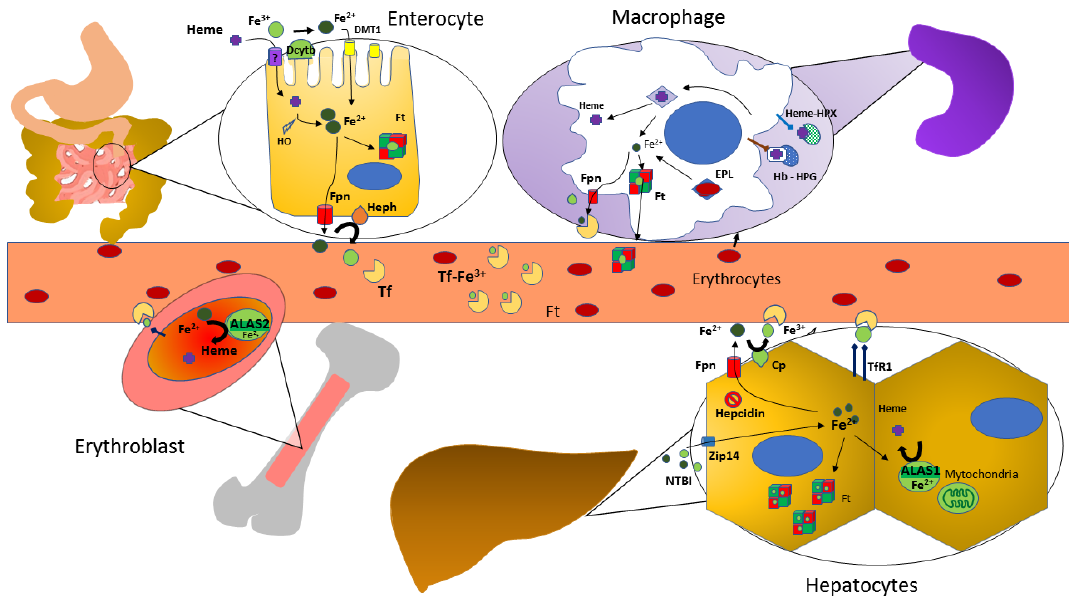
Figure 1. Iron Metabolism in the Human Body. Abbreviations: DMT-1, divalent metal transporter 1; Dcytb, duodenal cytochrome B; HO: heme oxygenase; Ft, ferritin; Fpn, ferroportin; Heph, hephaestin; Tf, transferrin; EPL, erythrophagolysomes; Cp, ceruloplasmin, ferroxidase activity; Hb, hemoglobin; HPX, hemopexin; HPG, haptoglobin; NTBI, non transferrin-bound iron; TfR1, transferrin receptor 1; ALAS, aminolevulinate synthase.